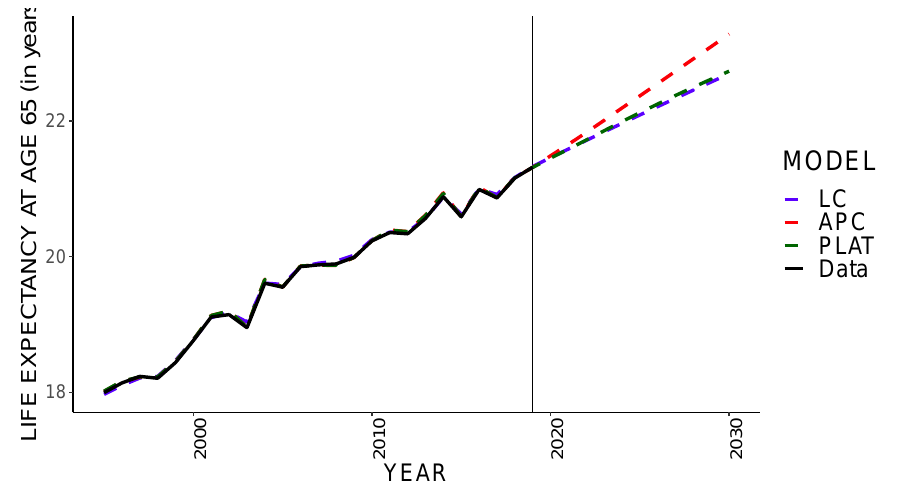
Figure A8. Comparison of LC, APC and PLAT Stochastic Mortality Models: projections of life expectancy at age 65 over the period